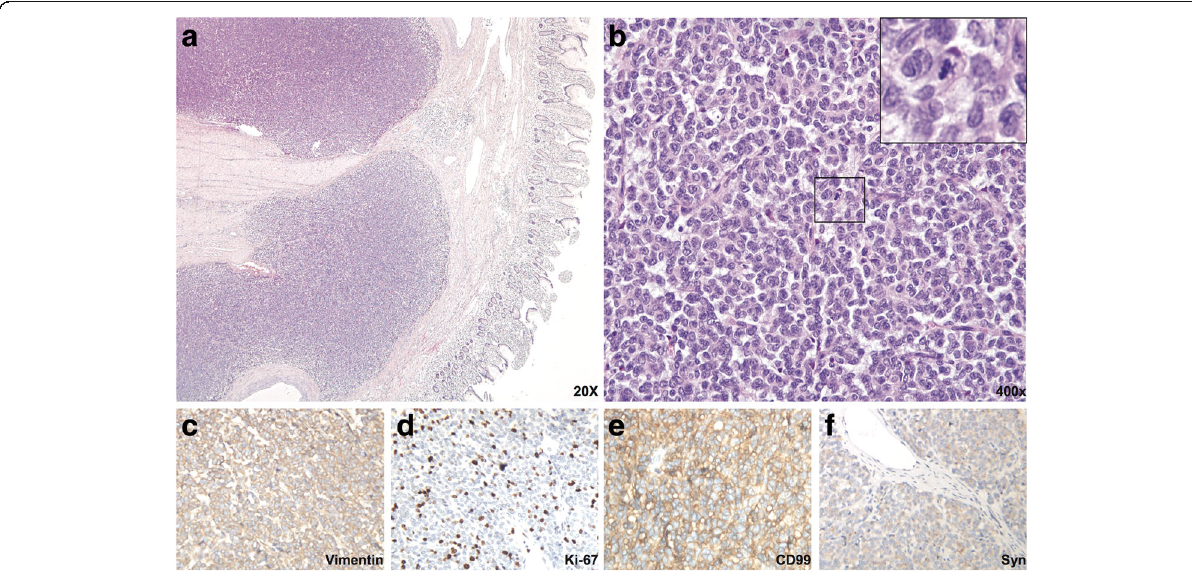
Fig. 3 Histological and immunohistochemical features of the intestinal tumor. a Low-power view with HE staining indicates sheets of tumor cells invading the myometrium and submucosa. b High-power HE view suggests that the tumor cells are small, round and form Homer-Wright structures. The boxed region is amplified in the upper right corner and is used to show pathological mitosis. c - f The tumor is positively stained for Vimentin, Syn, CD99, and the Ki-67 index is high (~40%). All immunohistochemistry images were taken under 200×